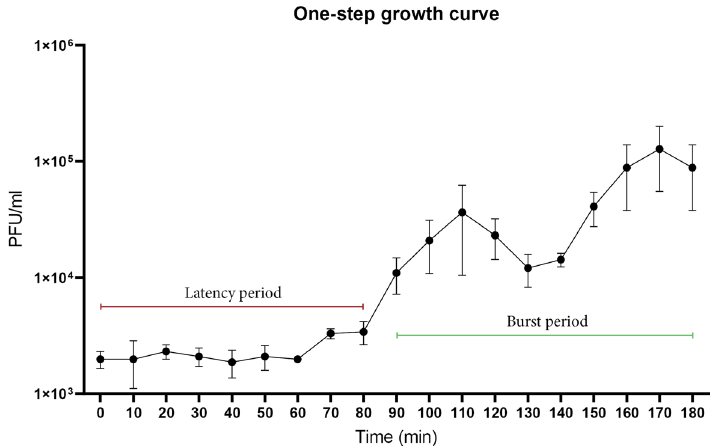
Figure 4. One-step growth curve. At MOI = 0.01, phage Pablito had a latent period of 80 min and a second burst at 150 min with a total burst size of 22 virions per cell.